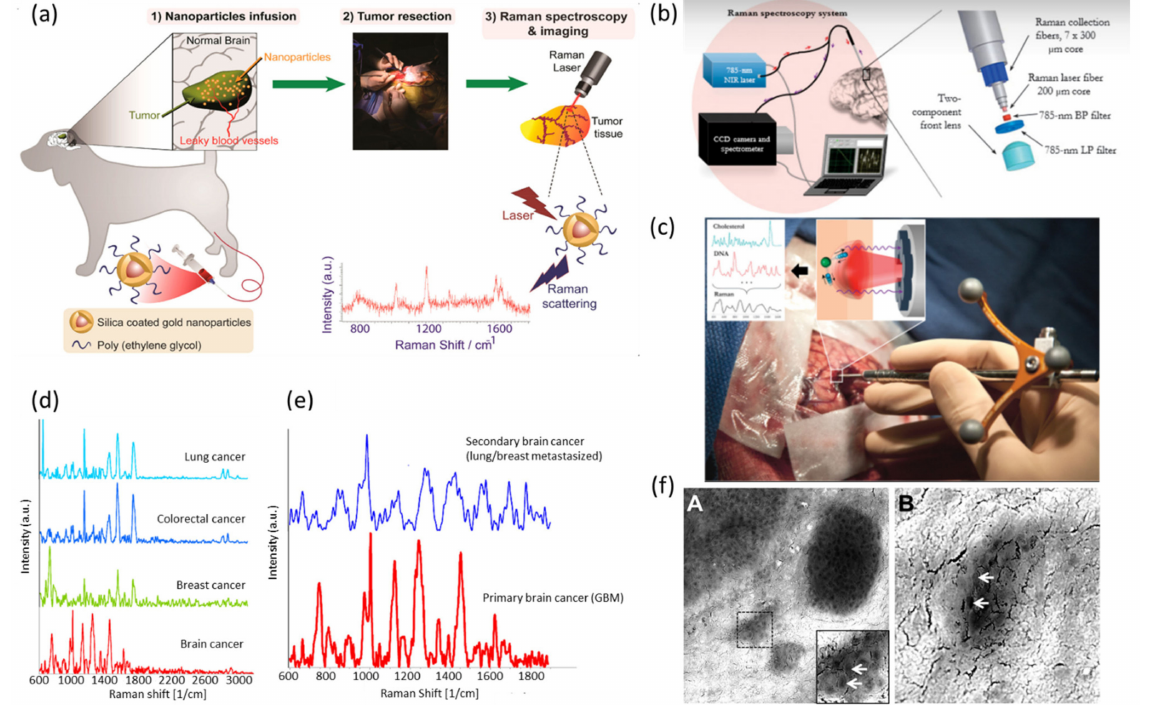
Figure 6. Illustration of applicability of Raman techniques in diagnosis of brain tumors. ( a ) Schematic showing the overall design of the experiments starting from nanoparticle preparation to intravenous infusion, surgical resection, and analyses. Adapted with permission from Reference [128] © 2019 American Chemical Society. ( b ) Experimental setup diagram with the 785 nm NIR laser and the high-resolution CCD spectroscopic detector used with the Raman fiber optic probe. ( c ) The probe (Emvision, LLC) used to interrogate brain tissue during surgery. Inset shows the excitation of dif- ferent molecular species, such as cholesterol and DNA, to produce the Raman spectra of cancer versus normal brain tissue. Adapted with permission from Reference [138] © 2015 Science. ( d ) SERS spectra of sera from brain, breast, lung, and colorectal cancer. ( e ) Raman spectral profiles of serum of brain cancer patients and serum of metastasized brain cancer. Adapted with permission from Refer- ence [129] © 2022 American Chemical Society. ( f ) ( A ) CARS image of a human U87MG glioblastoma in a mouse brain and ( B ) CARS image of a separate small glioblastoma island in a mouse brain. Single cell nuclei appear as dark structures in the tumor denoted by arrows. Adapted with permission from Reference [147] © 2014 Public Library of